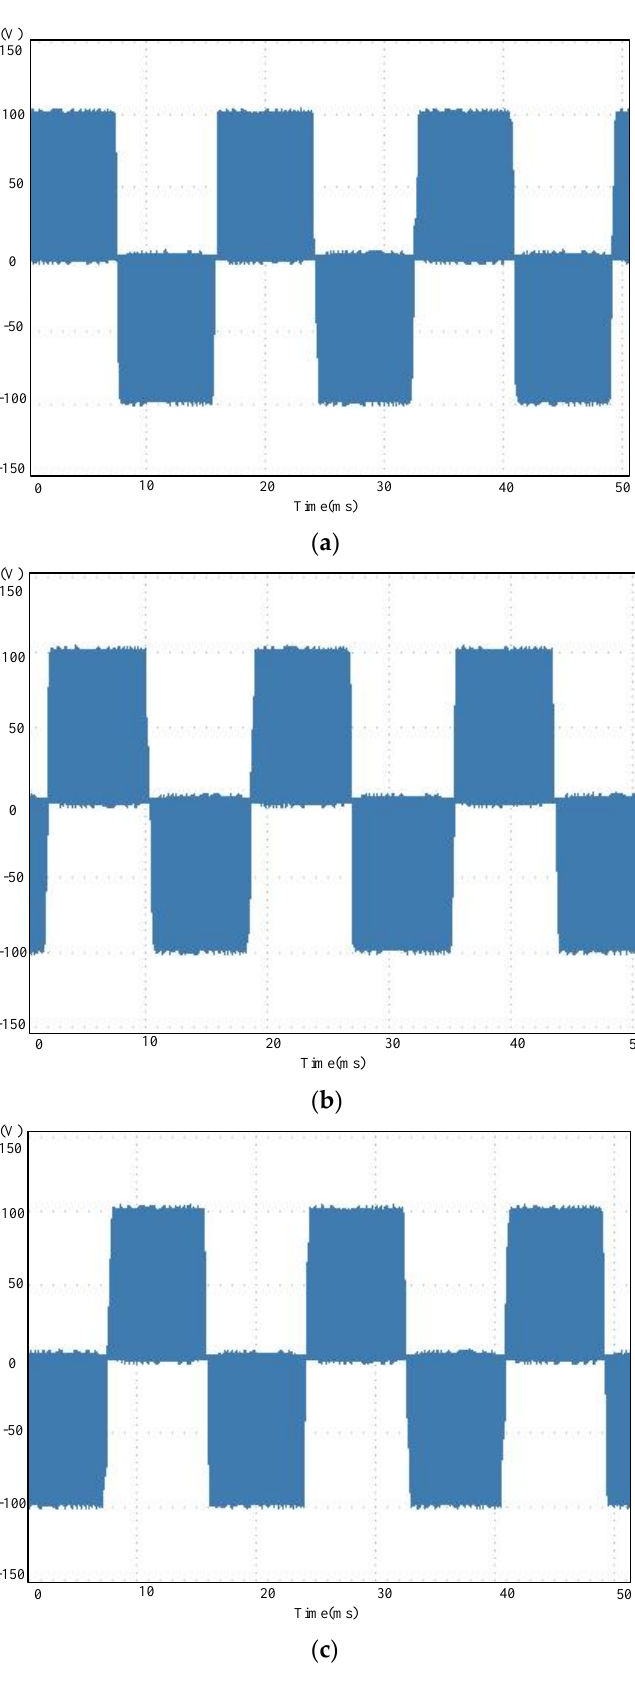
Figure 4. Output voltage waveforms of the inverter at a working frequency of 60 Hz with no switch faults: ( a ) phase voltage v ao ; ( b ) phase voltage v bo ; ( c ) phase voltage v co .